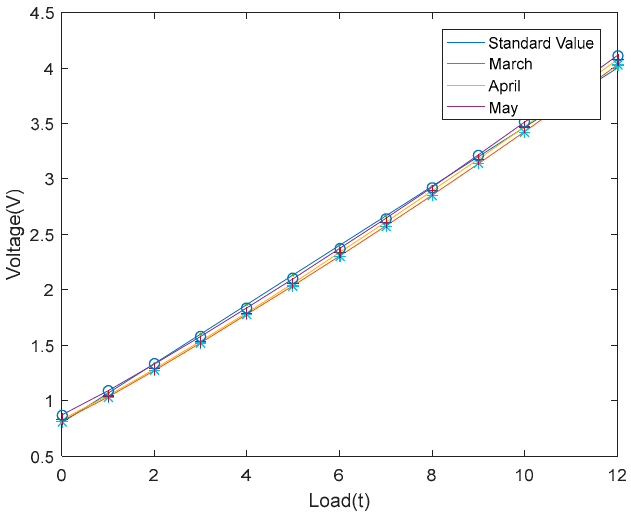
Figure 17. Stability experiment results of the